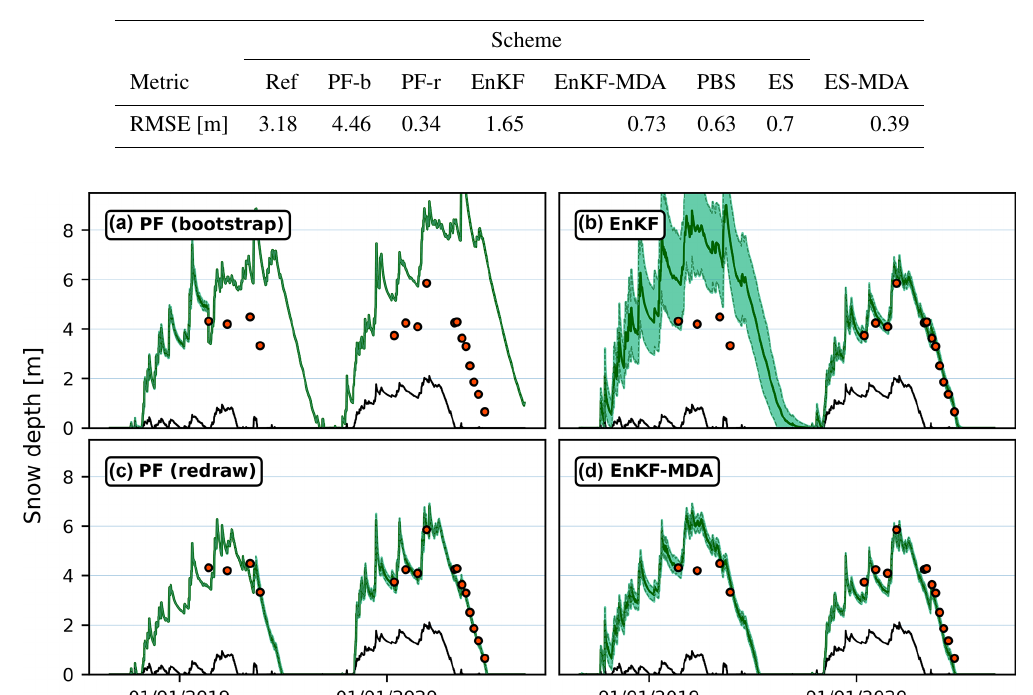
Table 1. RMSE for the reference run (Ref), particle filter with bootstrap resampling (PF-b), particle filter with redraw resampling (PF-r), ensemble Kalman filter (EnKF), ensemble Kalman filter with multiple data assimilation (EnKF-MDA), particle batch smoother (PBS), en- semble smoother (ES), and ensemble smoother with multiple data assimilation (ES-MDA). These errors were computed using the assimilated drone-based snow depth observations as the truth and using the posterior ensemble mean as the estimate from the respective DA schemes. All the schemes were run with N e = 200 particles, and the MDA schemes used N a = 4 iterations.